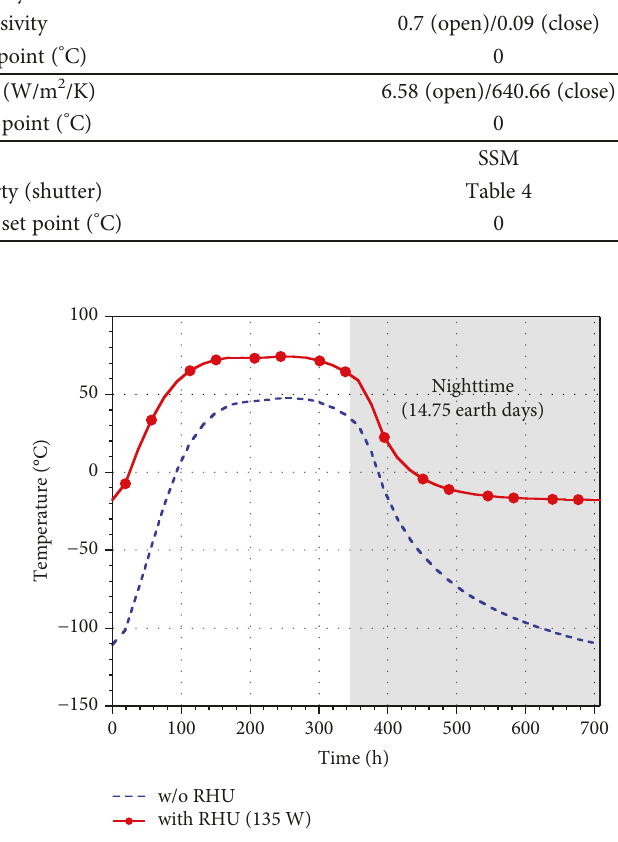
Figure 5: Temperature pro fi les of the lunar lander with and without RHU when applying SSM radiator.